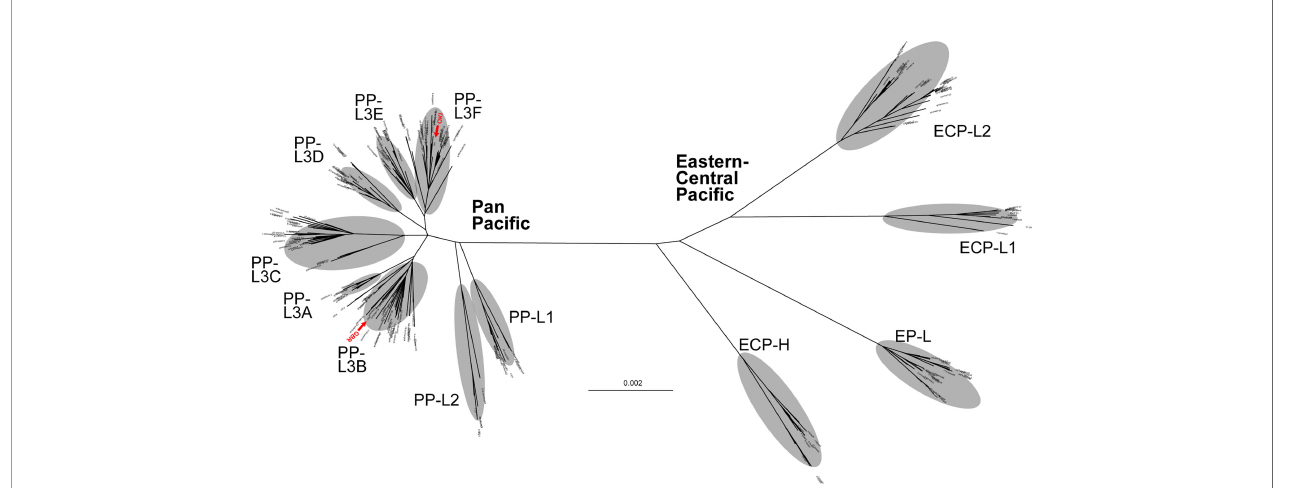
FIGURE 2 | An unrooted phylogenetic tree of individual COTS using the maximum-likelihood (ML) method, based on entire mitochondrial genome sequences (16,218 bp, including 1,822 variable sites), indicating the separation of two clades, Eastern-Central Paci fi c and Pan Paci fi c. Red arrowheads indicate sequences (OKI and GBR) decoded in the genome paper (Hall et al.,